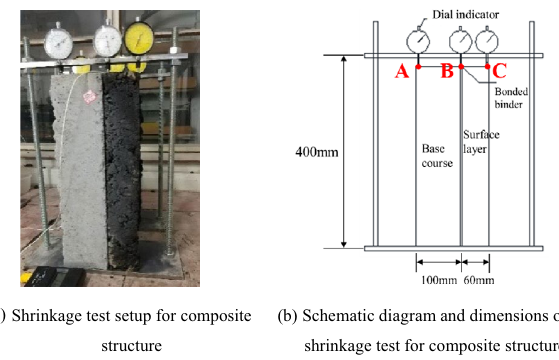
Figure 11. Shrinkage coefficient measurement setup for the pavement composite